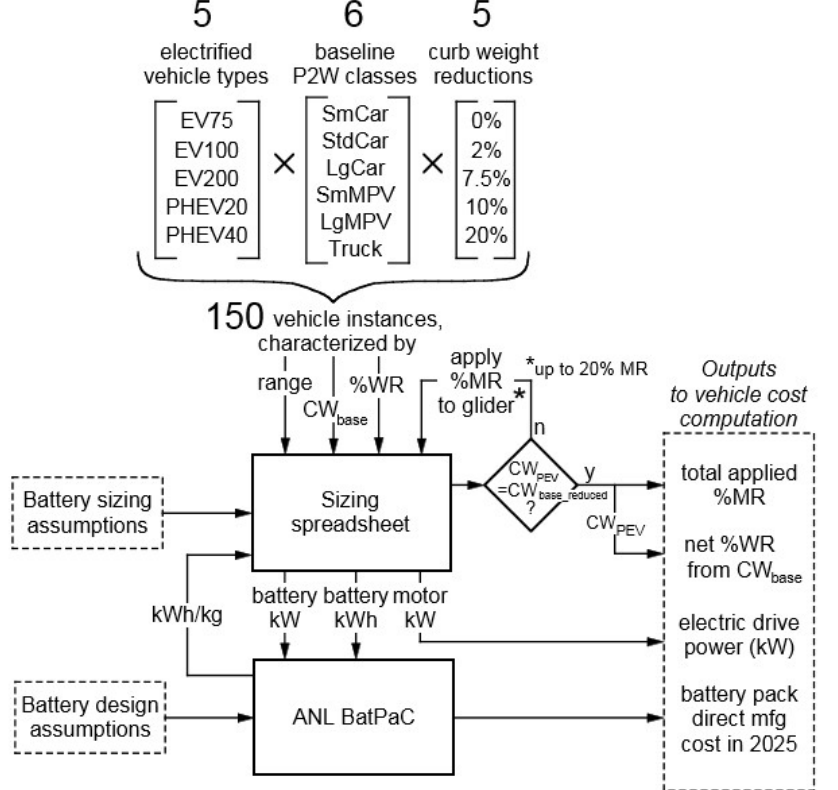
Figure 1. Analysis structure for vehicle battery sizing and cost estimation. Key: P2W, power-to-weight class; CW, curb weight; WR, curb weight reduction; MR, glider mass reduction.